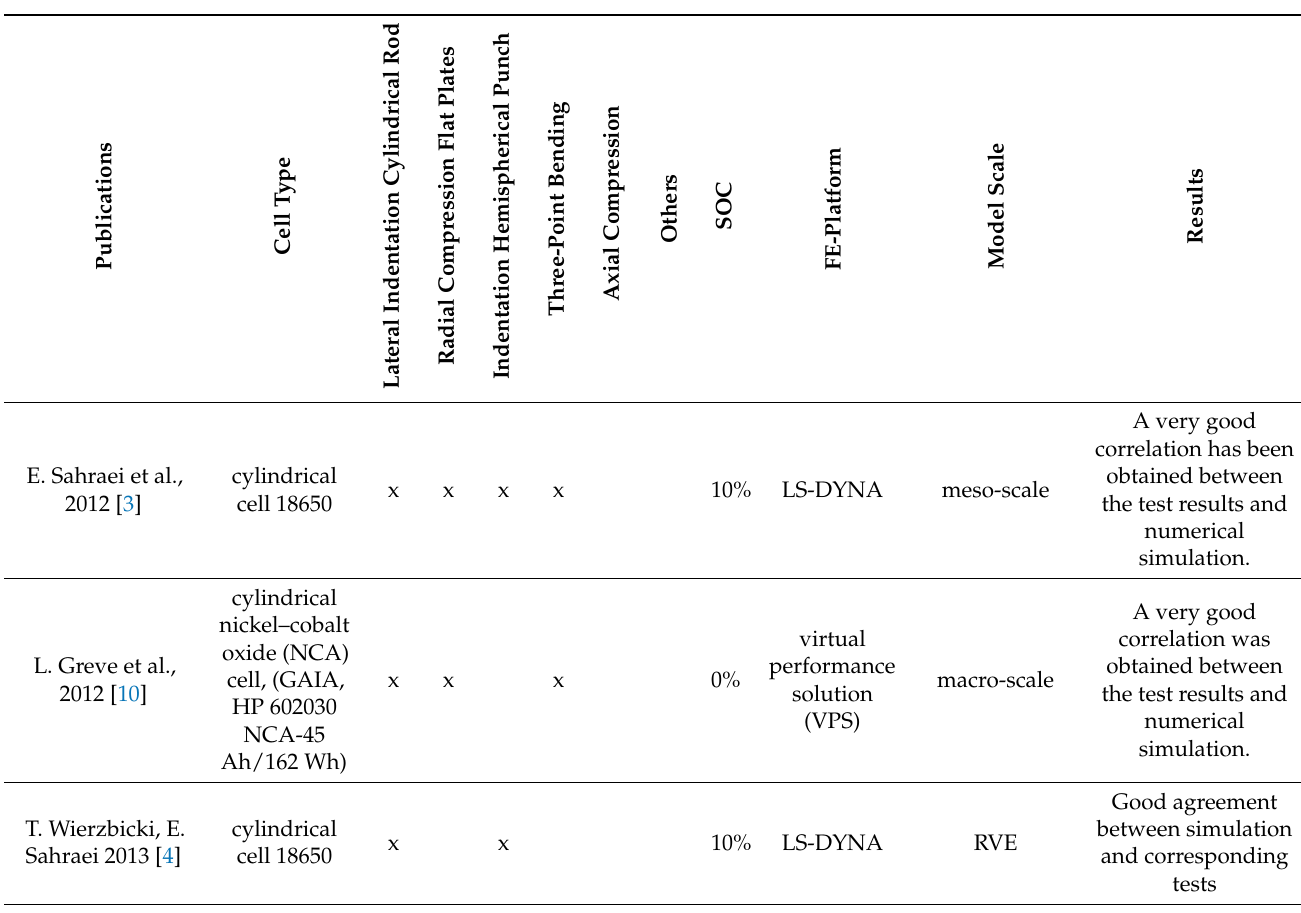
Table A1. Summary of the publications regarding mechanical testing of cylindrical cell